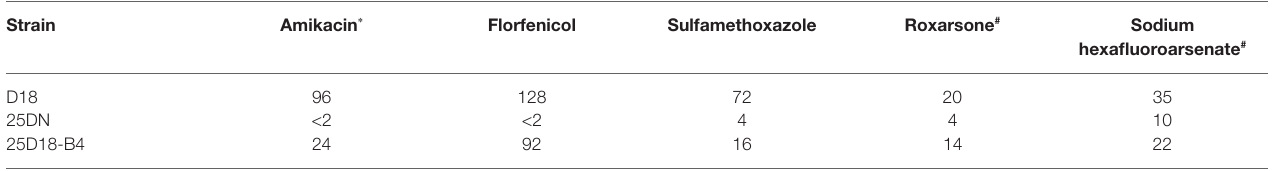
TABLE 1 | MICs of antibiotics and arsenic